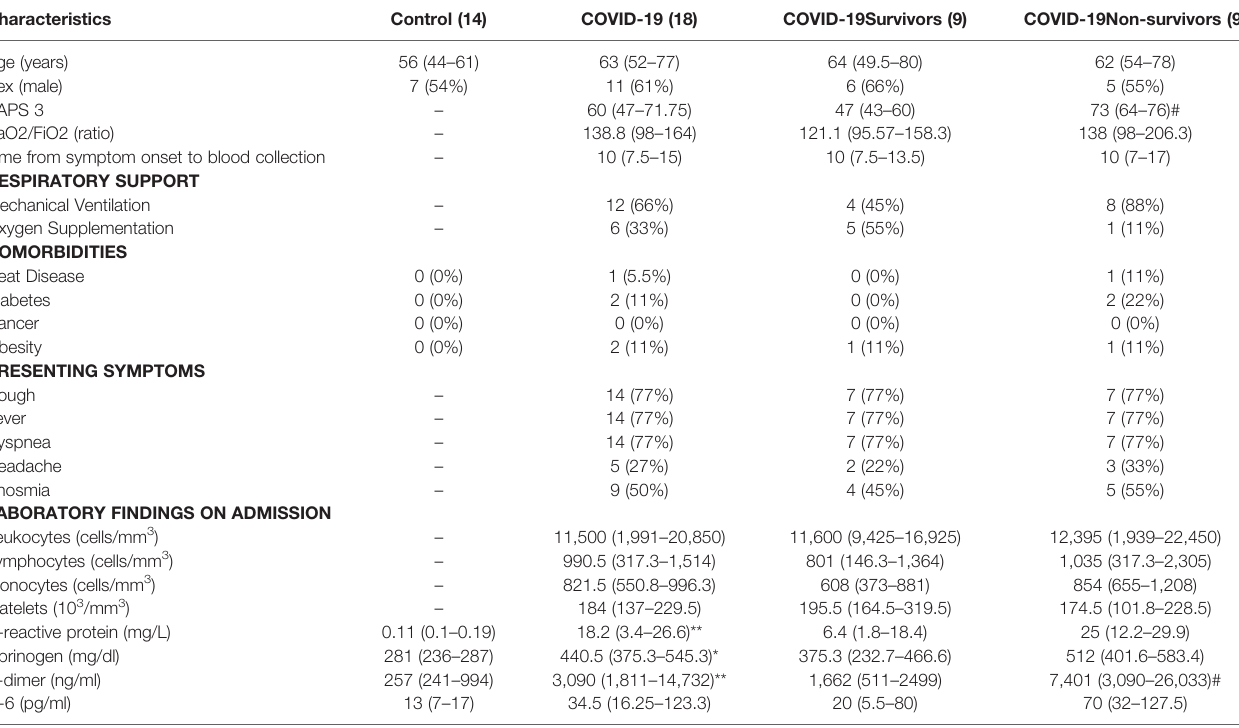
TABLE 2 | Clinical Characteristics of COVID-19 patients and control subjects in the fl ow cytometry cohort.